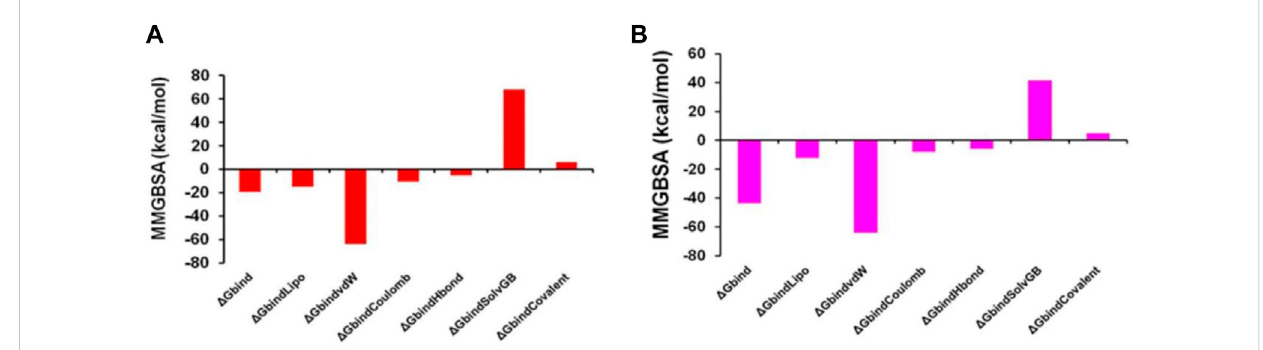
FIGURE 15 Graphical depiction of Binding energies of ZINC000252286875 for (A) 3KV2-Protonated and the (B) 3KV2-non-Protonated interaction energies from MMGBSA